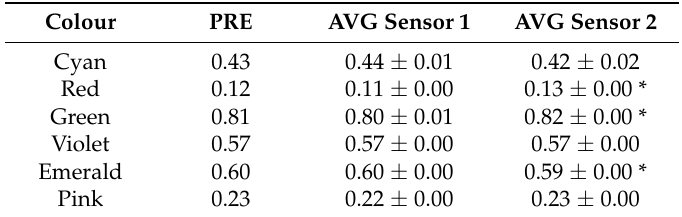
Table 3. Averaged NDVI measurements from the two N-sensors ± 1 standard error for each sensor with an asterisk indicating significant differences between Sensors 1 and 2 (two sample t -test, * p < 0.05). PRE = predetermined NDVI